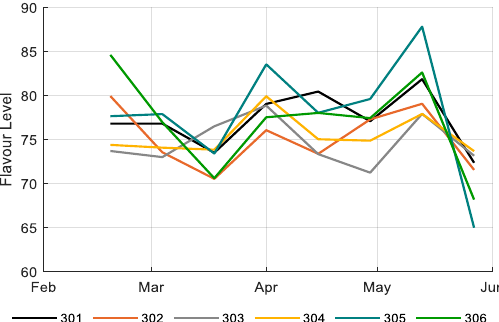
Figure 18. Flavor of tomato fruits (0 = dislike, 100 = like) based on calculations with WUR Flavor Tomato Model version 2.1 (2011), fruits from different greenhouse compartments (301–306).